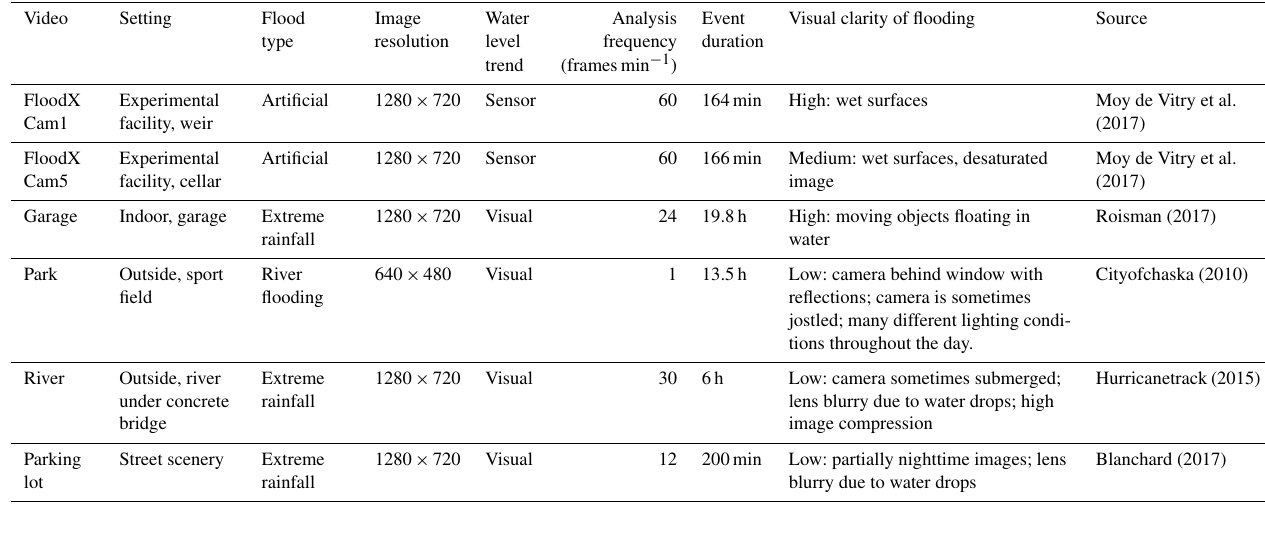
Table 2. Surveillance footage used in study.